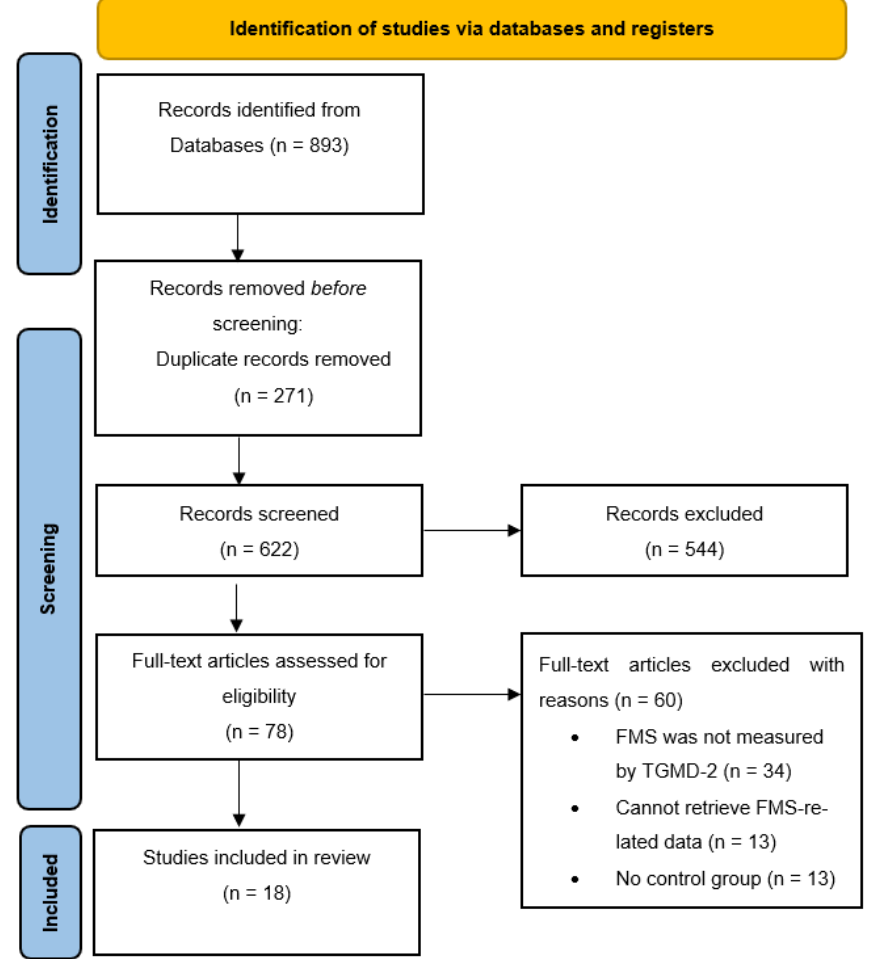
Figure 1. PRISMA flow chart for systematic reviews.